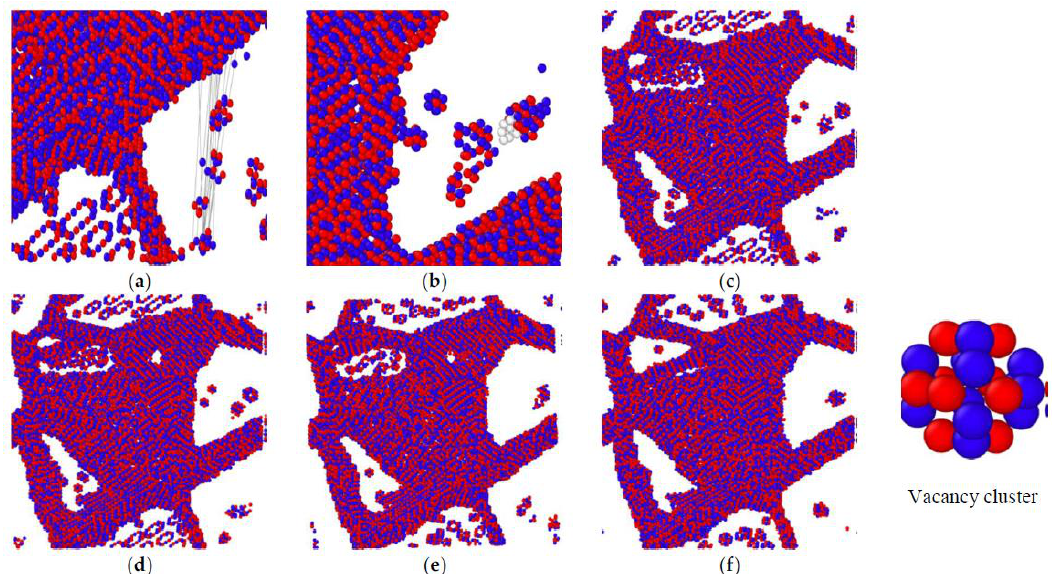
Figure 7. The distribution of the point defect after annealing. ( a ) the precipitate atoms from which from grain boundaries comes when temperature rises, and the gray lines are the atomic trajectory; ( b ) the white atoms adsorb on the atom clusters which are precipitated from the grain boundaries; ( c – f ) is the distribution of the point defects in the grain after annealing in Case 1, Case 2, Case 3, Case 4.